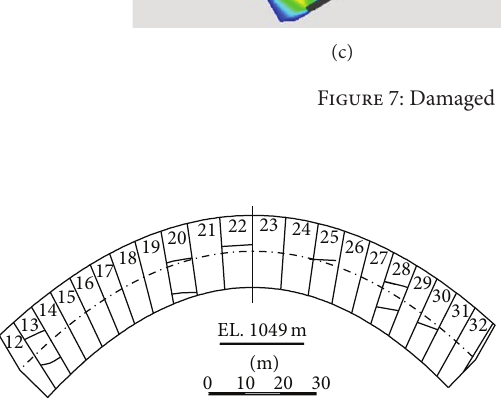
Figure 8: Distribution of cracks on typical